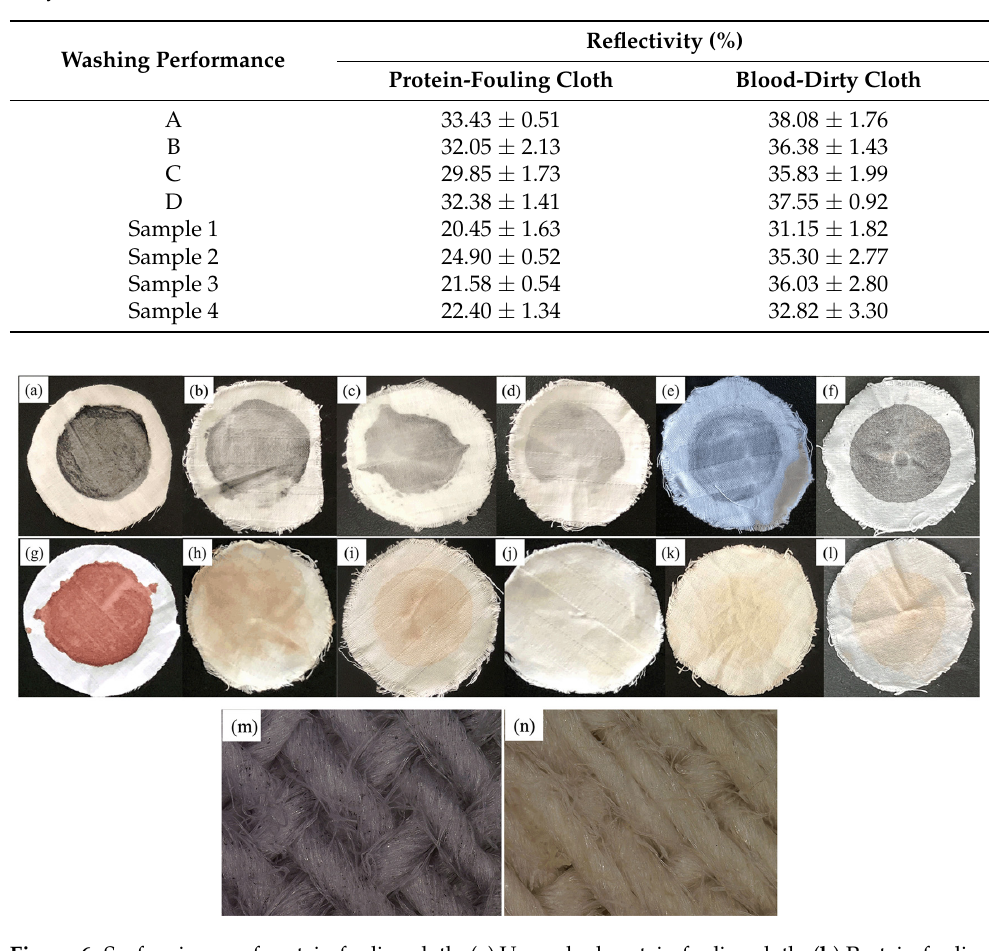
Figure 6. Surface image of protein-fouling cloth. ( a ) Unwashed protein-fouling cloth. ( b ) Protein-fouling cloth after alkaline protease washing. ( c ) Protein-fouling cloth after keratinase washing. ( d ) Protein- fouling cloth after trypsin washing. ( e ) Protein-fouling cloth after complex enzyme detergent. ( f ) Protein-fouling cloth after commercial detergent. Surface image of blood dirty cloth. ( g ) Unwashed blood-dirty cloth. ( h ) Blood-dirty cloth after alkaline protease washing. ( i ) Blood-dirty cloth after keratinase washing. ( j ) Blood-dirty cloth after trypsin washing. ( k ) Blood-dirty cloth after complex enzyme detergent. ( l ) Blood-dirty cloth after commercial detergent. Microscopic images of protein stains after washing protein stains with protease liquid detergent. ( m ) Protein-fouling cloth after washing (500 × ). ( n ) Blood-dirty cloth after washing (500 ×